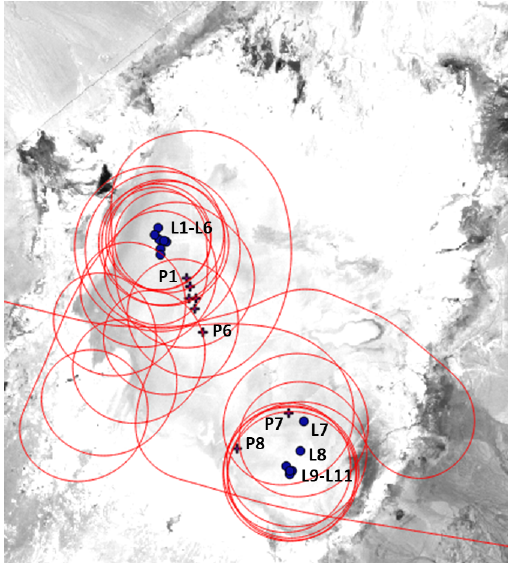
Figure 5. Position of the PARABOLA sites are marked in black (numbered P1-P8) and the centers of each CAR loop are marked in blue (labeled L1-L11). The aircraft track is marked in plain red. Loops 1 to 6 (labeled as L1–L6) were performed at an altitude of ∼ 650 m above the ground, loops 7 to 11 (labeled as L7–L11) at an altitude of ∼ 200